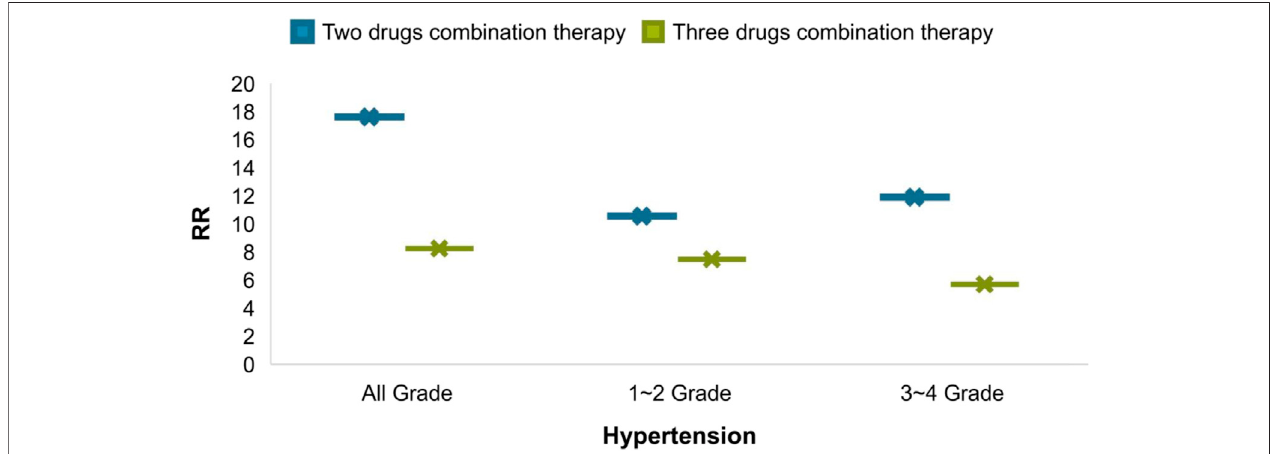
FIGURE 6 | Comparison of RR of hypertension caused by cancer combination therapy regimens.